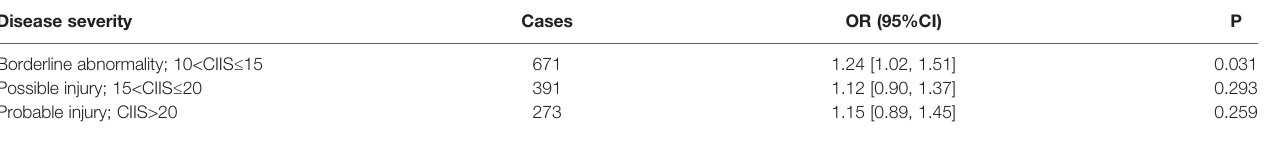
TABLE 5 | The association between C-peptide and severity of